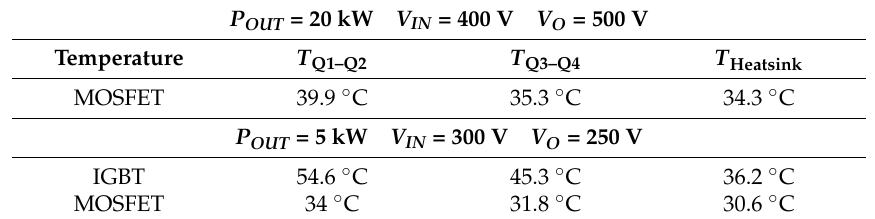
Table 4. Temperature Measurements for SiC MOSFET and Si IGBT after 15 min for 5 kW and 20